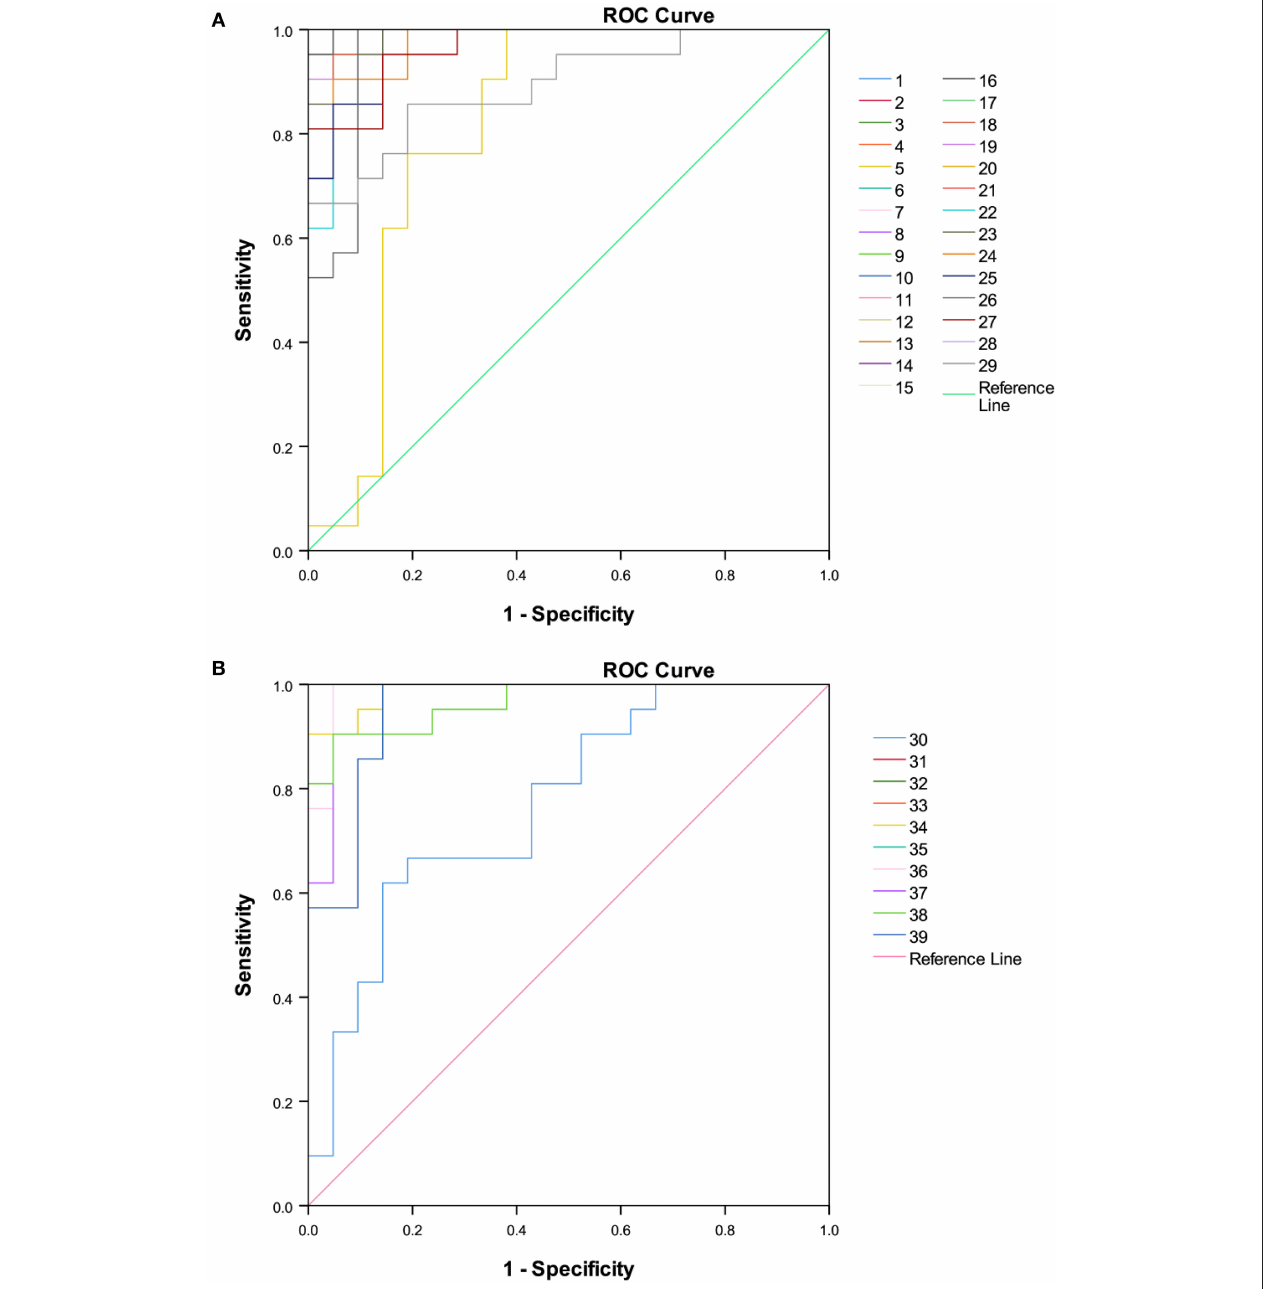
FIGURE 8 | Receiver operating characteristic curve (ROC) of 39 potential chemical markers selected by variable influences in projection (VIP) values. (A) Features with higher quantity level in PE. (B) Features with higher quantity level in Ganpu